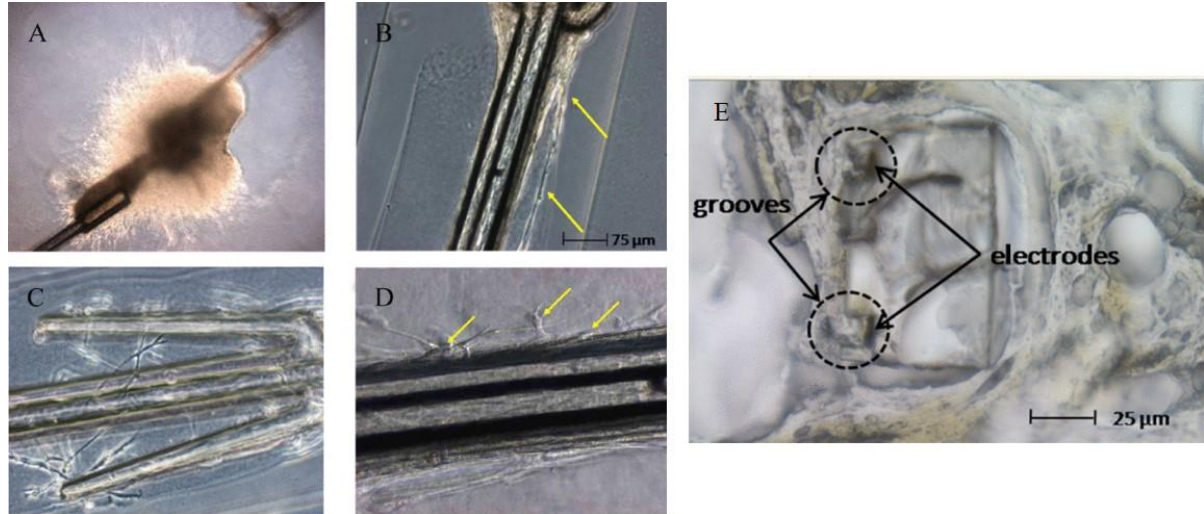
Figure 2. Optical images of: ( A ) explanted DRG from four-day old rat, cultured for 14 days on two separate SU-8 microprobes shown placed at 8 and 2 o’clock relative to the DRG explant; ( B ) neural fibers growing away from the DRG explants, adhering to every surface along the full length of the SU-8 microprobes which appear to be guiding the growth of fibers along its shaft (arrows); ( C ) its flexible wing extensions (calibration 75); ( D ) close up of neurons (arrows) migrating away from the DRG explants along the shaft of the SU-8 microprobe; and ( E ) cross-sectional view of the SU-8 microprobes recovered from regenerated peripheral nerves 17 weeks after tubulization showing that groove electrodes were filled with nerve tissue. Robust fiber spike signals (signal-to-noise ratio > 3) were recorded throughout this implantation period using these grooved electrodes © 2008 IEEE. Reprinted from Cho et al. [29] with